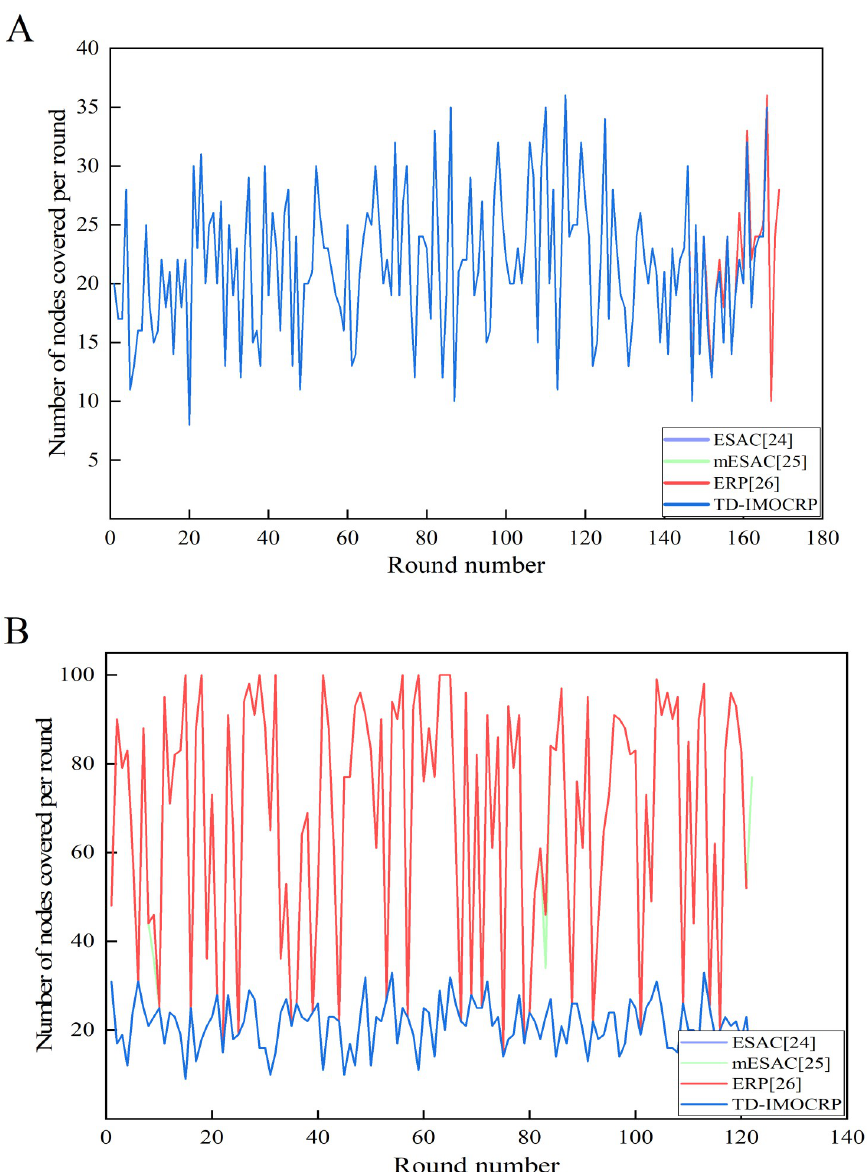
Fig 12. Comparison results of number of covered nodes per round. (A) The sink is located at the center. (B) The sink is located at